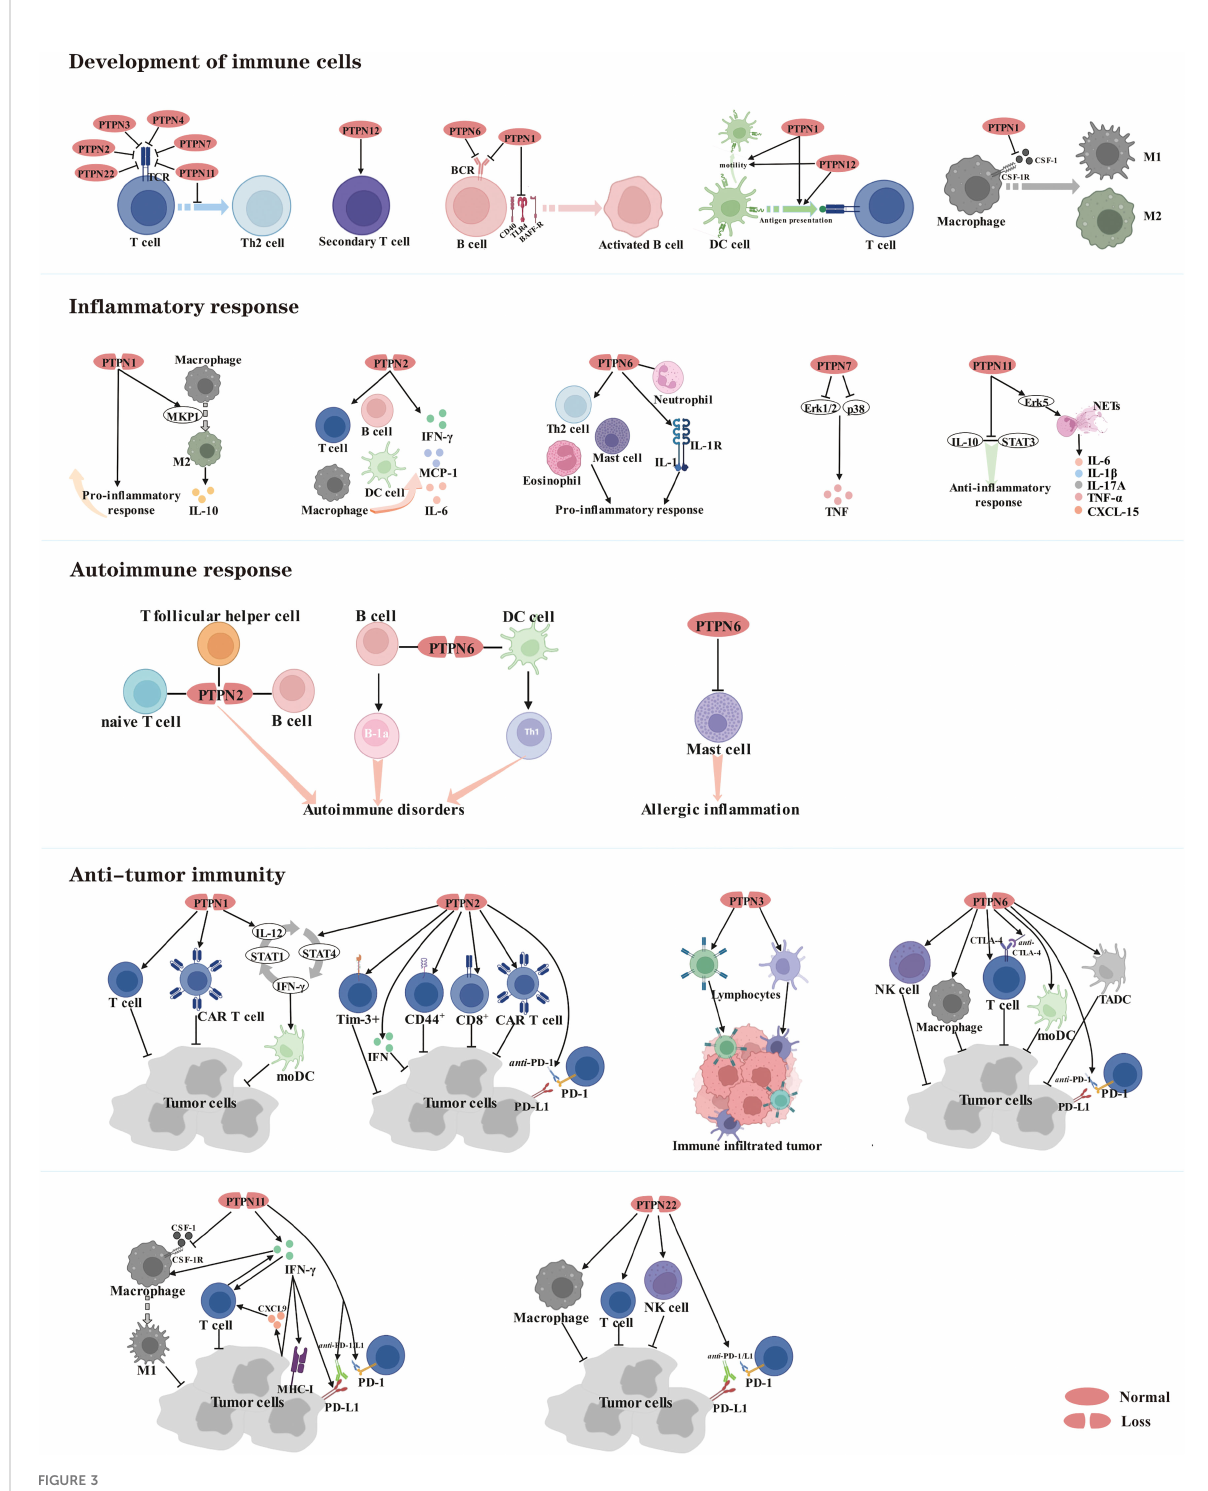
FIGURE 3 Members of the PTPN family are involved in regulating the development of immune cells and serve as therapeutic targets for in fl ammatory diseases, autoimmune diseases and